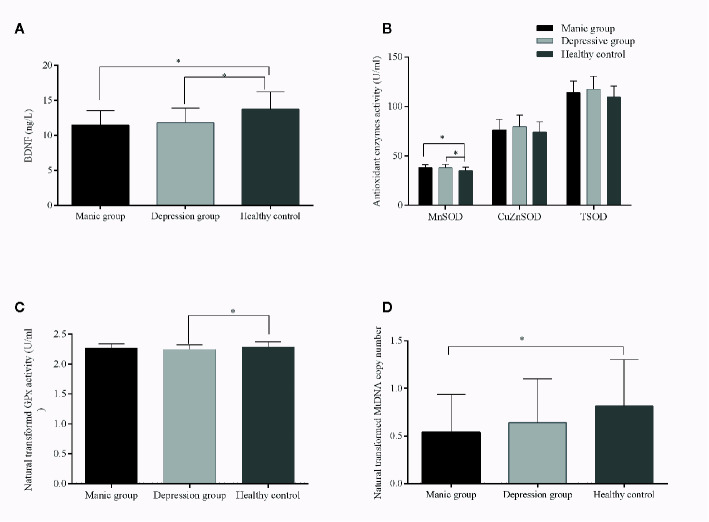
Brain-derived neurotrophic factor (BDNF) levels and TSOD, MnSOD, CuZnSOD, GPx enzyme activities, and mitochondrial DNA (mtDNA) copy number from patients with bipolar disorder and from healthy controls. The results are expressed as the mean+SD, * p ≤ 0.05 (controlled for age, gender, education, and BMI). Compared with controls, (A): lower levels of BDNF in manic and depressive patients; (B): increased MnSOD activities in manic and depressive patients; (C): decreased GPx activity in depressive patients; (D): lower mtDNAcn in manic patients.